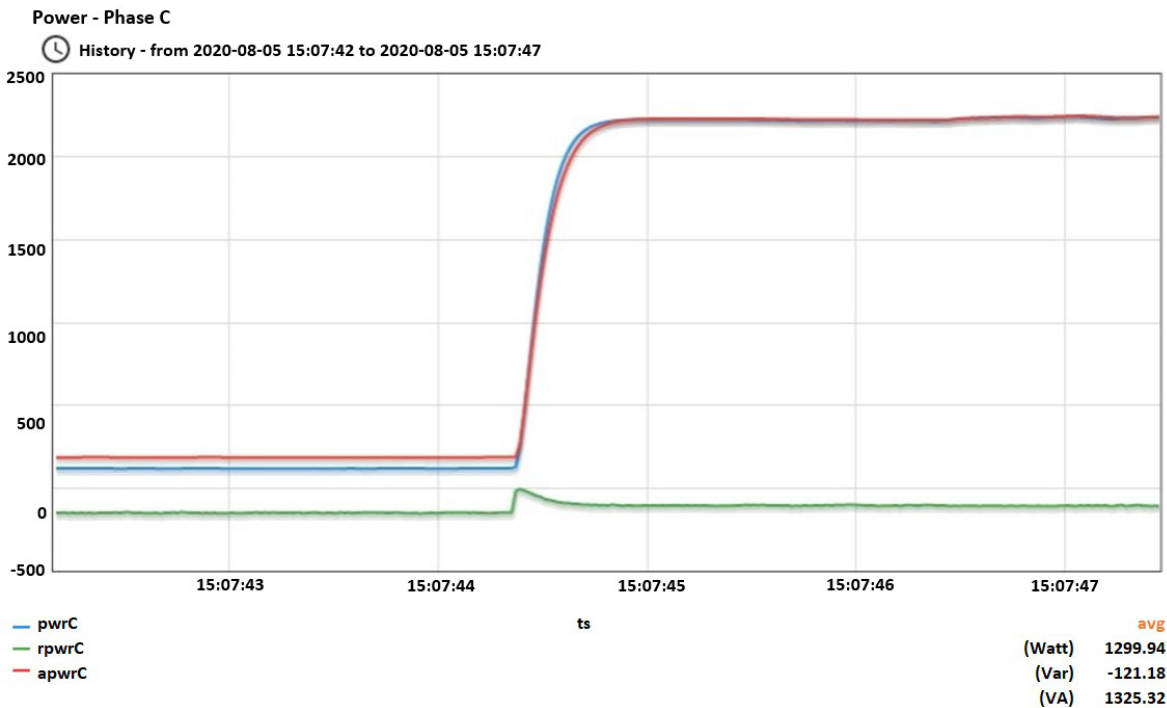
Figure 16. Stove’s behavior. The stove operated in a time period where no other device changed the state.